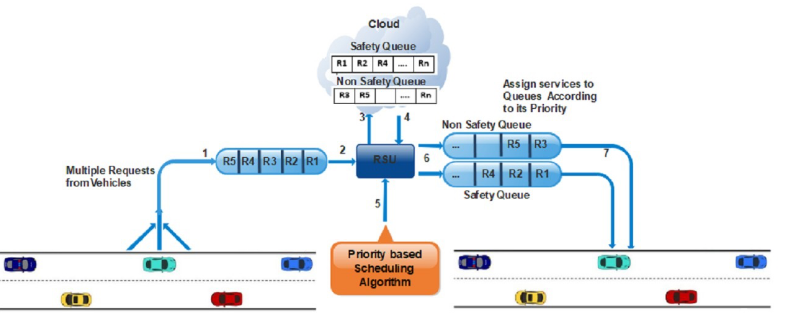
Figure 2. Services on priority-based scheduling.